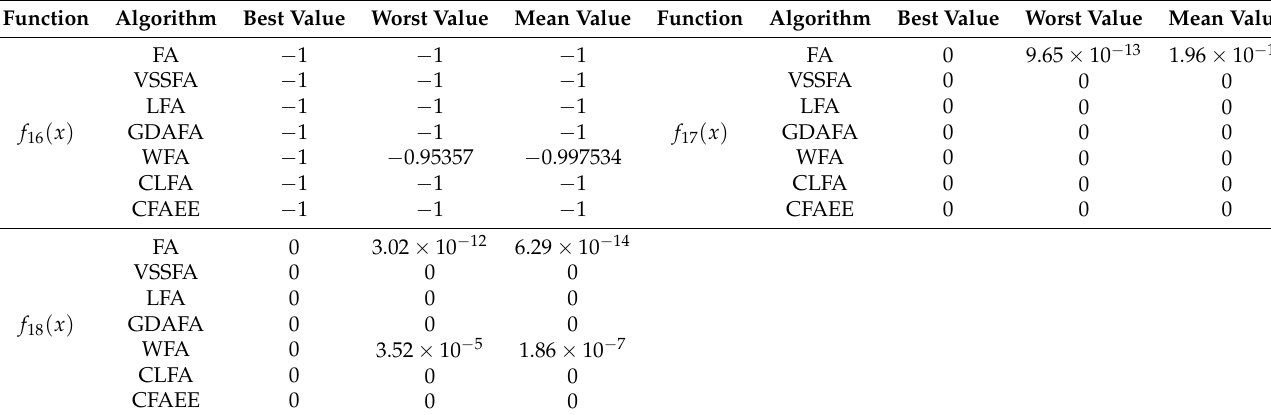
Table 6. Comparative analysis among CFAEE, original FA, and five other FA implementations for benchmarks with 2 dimensions.